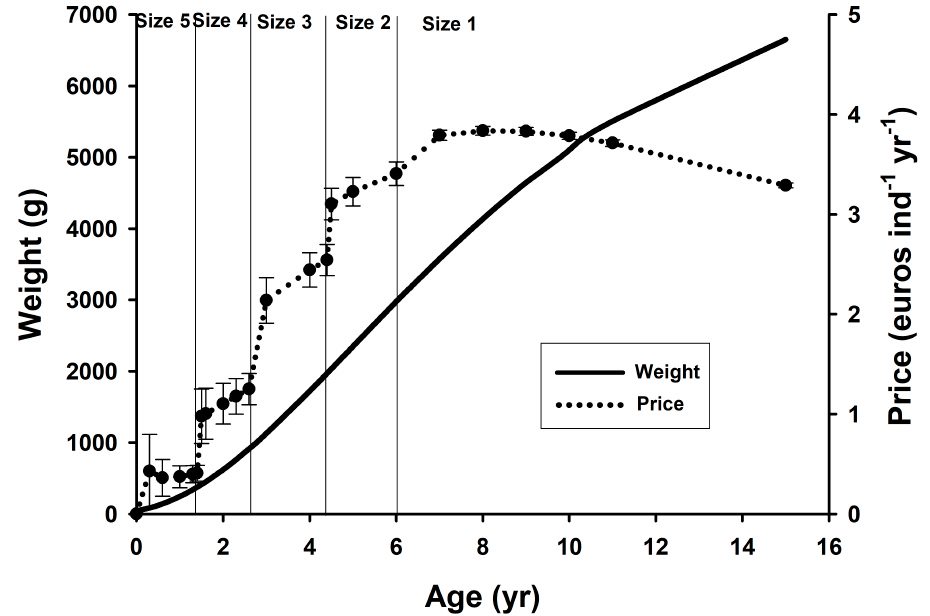
Figure 3. Growth of P. mediterraneus according to the published literature [46,47] (solid line), and selling prices per individual, i.e., the price that was obtained when it was sold divided by their age calculated through the von Bertalanffy equation (dotted line, mean ± SEM representing the differences between the years used for the calculation). Vertical lines represent the limits of the commercial sizes (1 to 5) in the fish market of Conil (south of Spain).